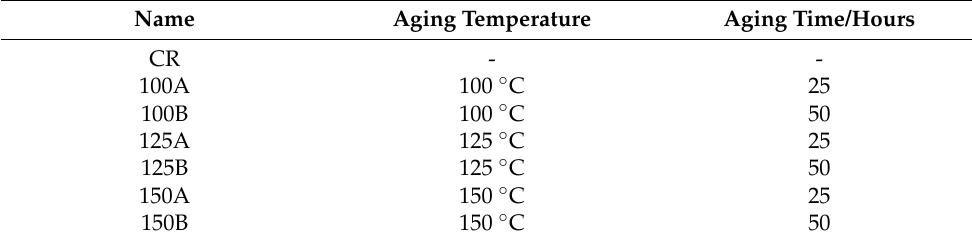
Table 2. Sample preparation method.